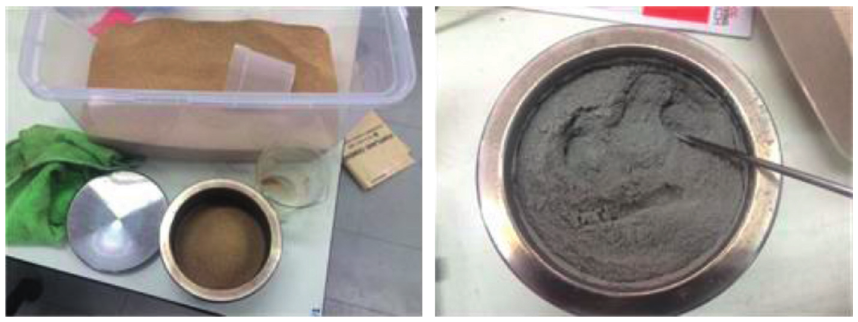
Figure 2: Sand powder (GS). Table 1: Chemical compositions of Portland cement type I, sand powder, and fly ashes.